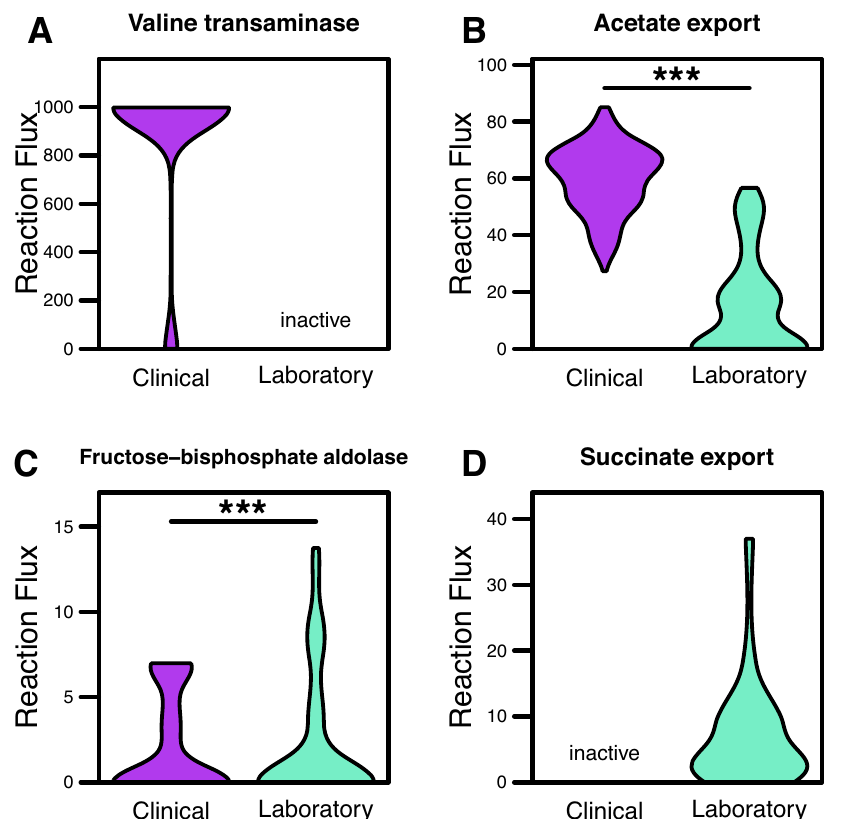
Fig. 5 Sampled reaction fl ux in the metabolic models demonstrates ability of clinical isolates to optimize use of valine transaminase. A Valine transaminase (converts L-valine and pyruvate to 3-methyl-2-oxobutanoate and L-alanine), B acetate transport via diffusion, C fructose-biphosphate aldolase (converts D-fructose to D-glyceraldehyde 3-phosphate and dihydroxyacetone phosphate), or D succinate transport via proton symport. Inactive label indicates reactions only present in one context-speci fi c model, and signi fi cant differences determined by Wilcoxon rank-sum test (*** p -value ≤